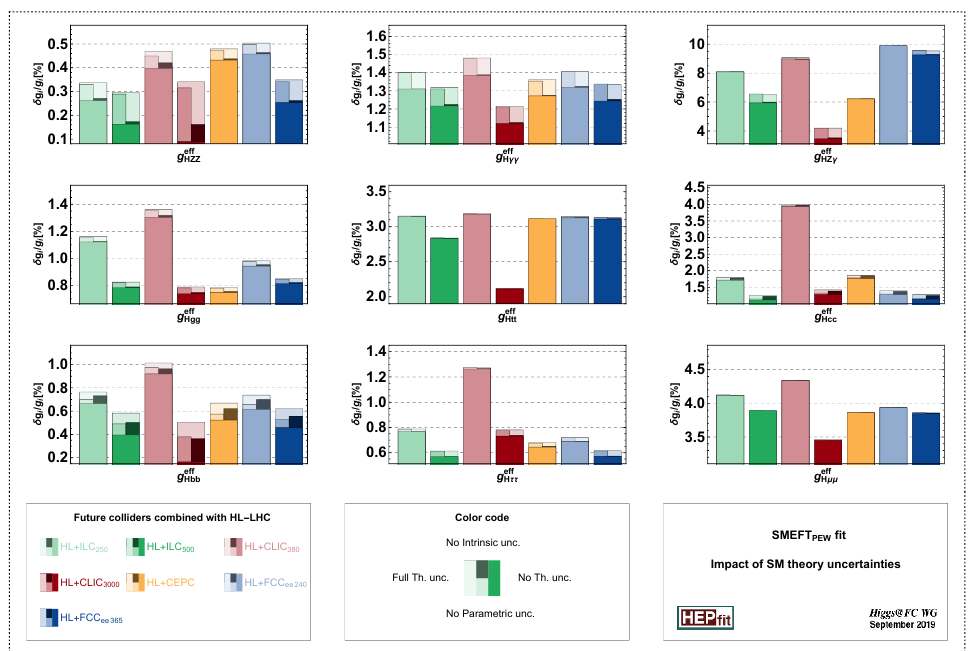
Figure 8 . Impact of the di(cid:11)erent sources of SM theory uncertainties in the coupling reach at the di(cid:11)erent lepton-collider projects based on the SMEFT PEW (cid:12)t. Using dark to light shades we show the results without SM theory uncertainties (darkest shade), only with the intrinsic uncertainty (medium), and the full SM error (lightest shade). The solid line indicates the result with SM parametric uncertainties only. The most signi(cid:12)cant di(cid:11)erences are found for the e(cid:11)ective coupling to vector bosons (dominated by intrinsic uncertainties) and to bottom quarks (controlled by the parametric error associated with m b ). See table 11 and text for